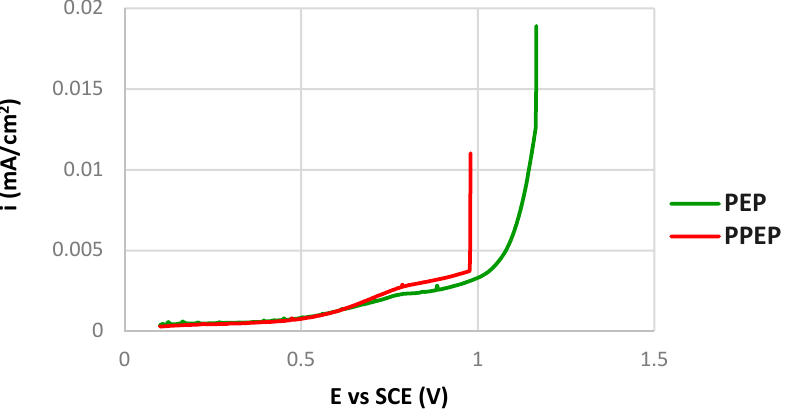
Figure 7. Detail of potentiodynamic polarization curves for tested surfaces in linear axes.